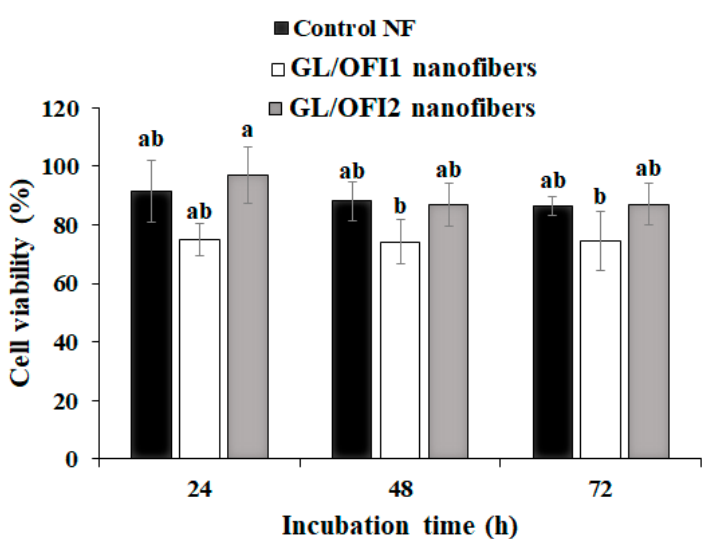
Figure 9. Viability of HDFa PCS-202-012TM cells in presence of GL/OFI1 and GL/OFI2 nanofibers. Data are shown as mean ± SD values. (a,b) Different letters indicate statistical differences between incubation times by each nanofiber using the Tukey test ( p < 0.05).